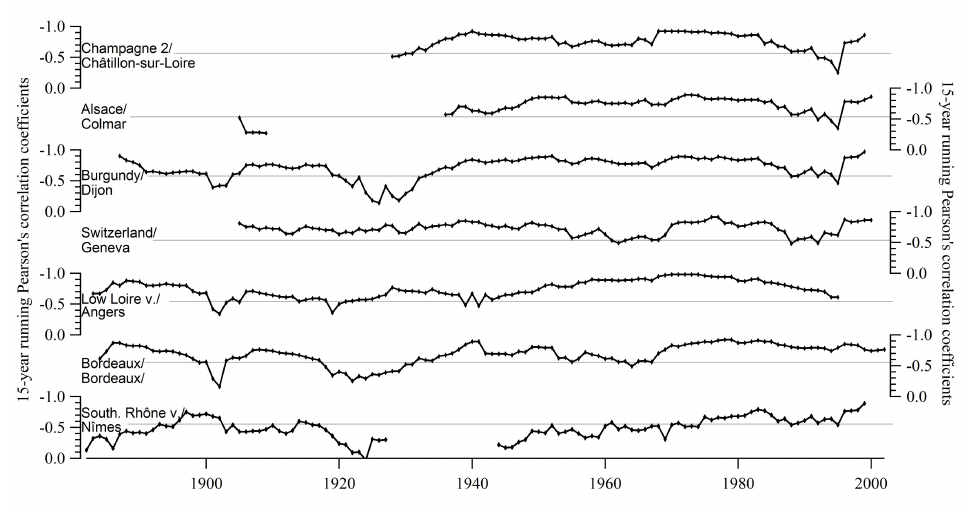
Fig. 5. Variation of the 15-yr running Pearson’s correlation coefficients of GHD-RCS– T AMJJAS max correlations, from top to bottom: Champagne 2 versus Chˆatillon-sur-Seine, Alsace versus Colmar, Burgundy versus Dijon, Switzerland versus Geneva, Low Loire Valley versus Angers, Bordeaux versus Bordeaux city and Southern Rhˆone valley versus Nˆımes. The horizontal lines correspond to the significance level of the PCC (at p = 0 .